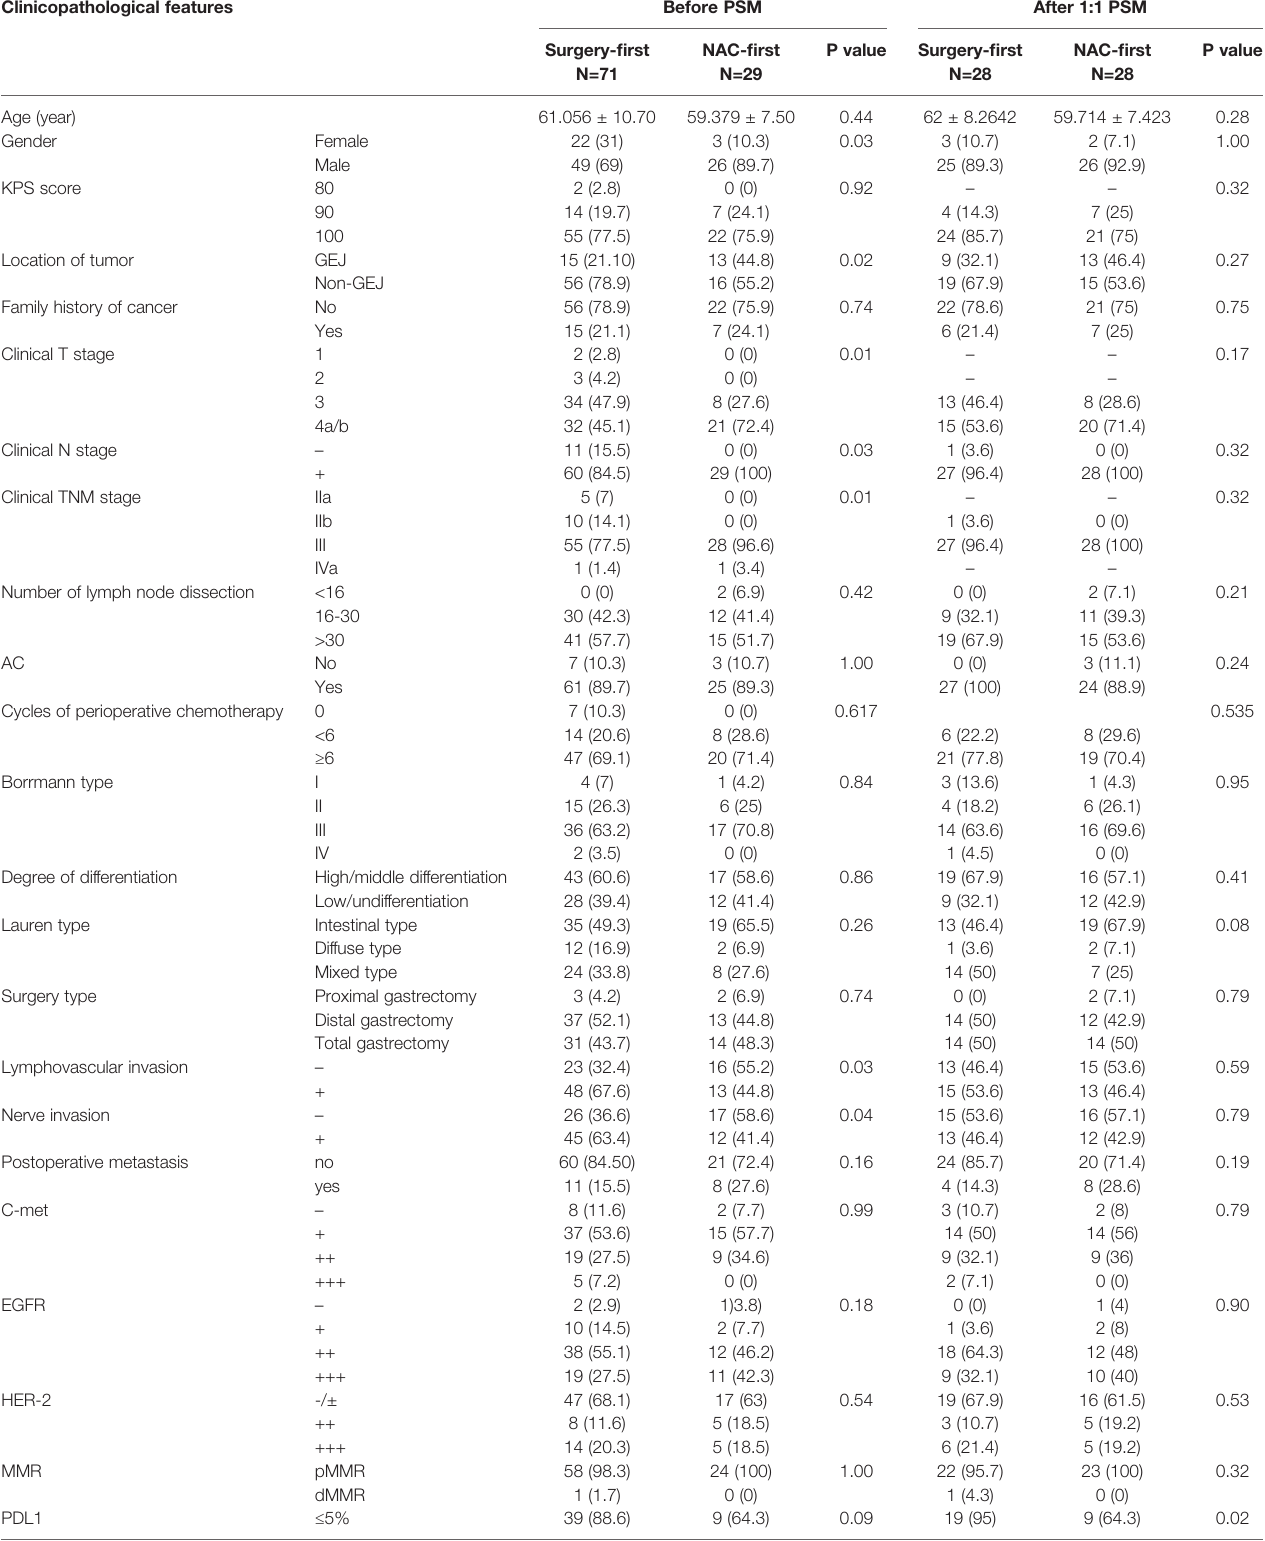
TABLE 1 | Baseline demographics of the study population before and after propensity score matching. Clinicopathological